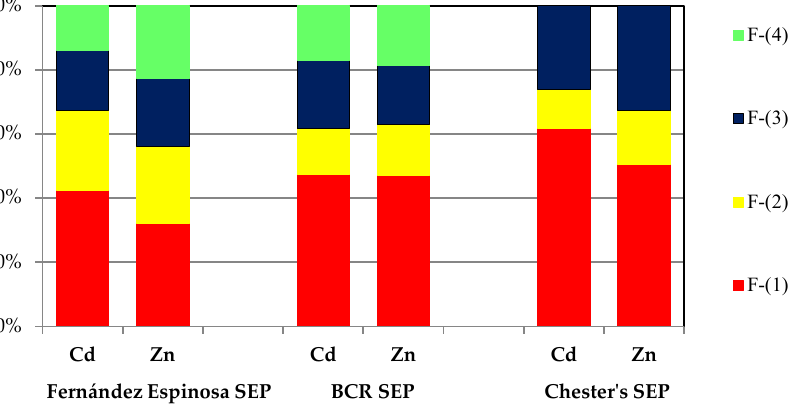
Figure 4. Comparison of the average operational speciation of cadmium and zinc in atmospheric particulate matter.